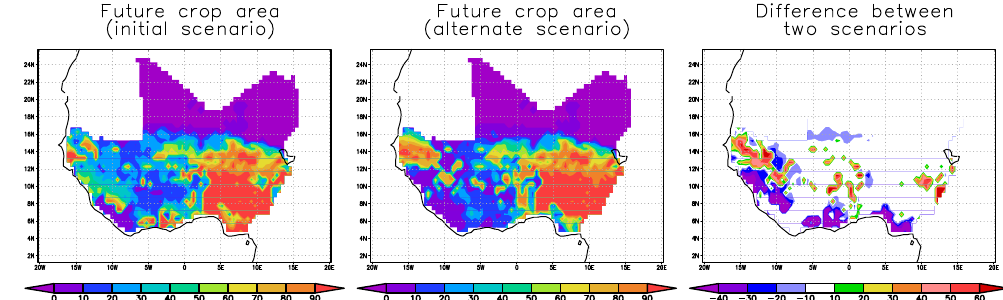
Figure 8. Future crop area coverage (%) in West Africa as projected by the LandPro algorithm under the MIROC-driven regional climate, based on the future scenario where forest is preferred over grass for crop area expansion (as shown in Fig. 1) and the alternate scenario where grass is preferred over forest, and the differences between the